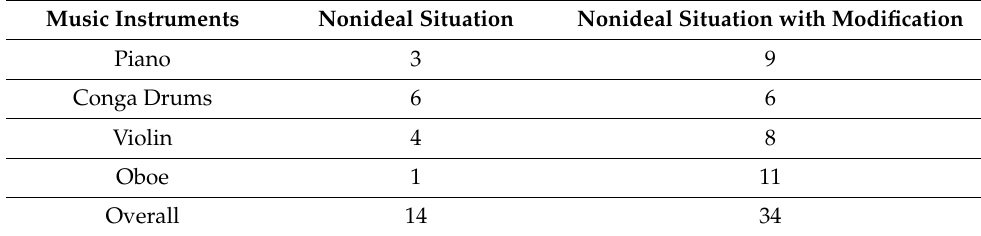
Table 4. Subjective listening scores of different musical instruments.